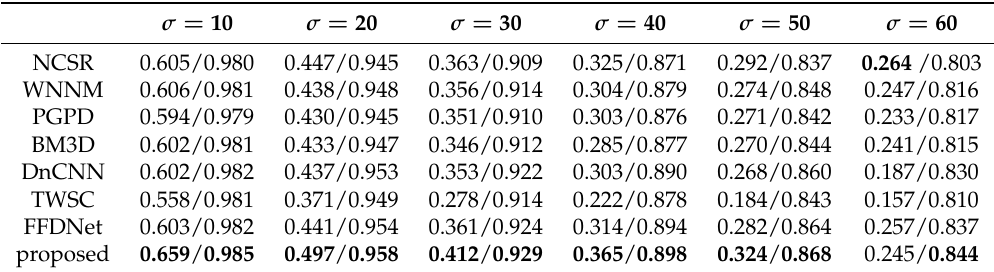
Table 6. Average VIF/IW-SSIM values of the competing methods obtained for 50 images selected from the BSD dataset with noise level σ = 10, 20, 30, 40, 50 and 60.